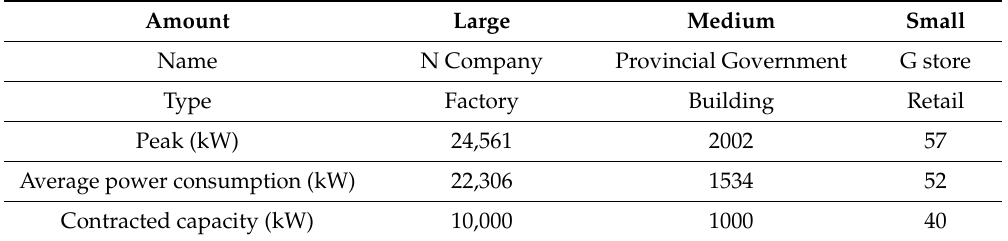
Table 5. The data for functional verification of demand-side management solution